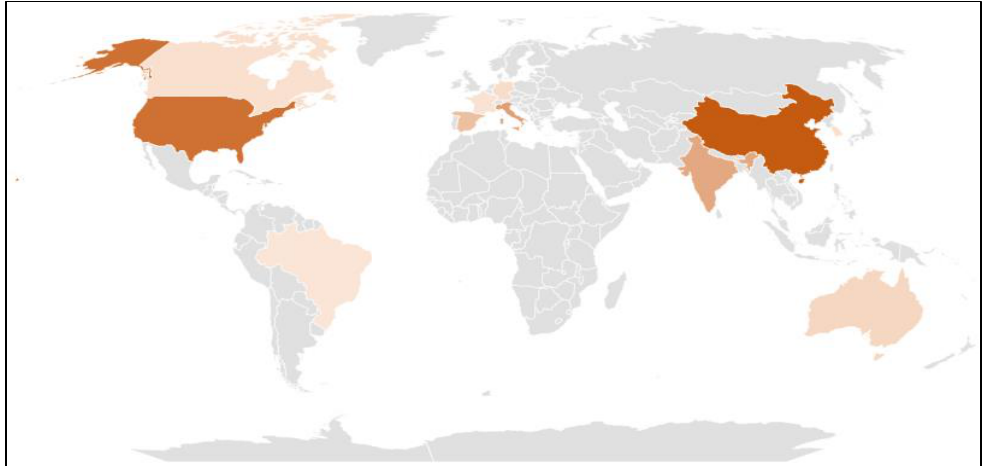
Figure 3. An overview of countries dealing with the topic of Smart cities. Source: own analysis as per Web of Science (2022). Table 2. Top eight countries dealing with the topic of Smart cities.